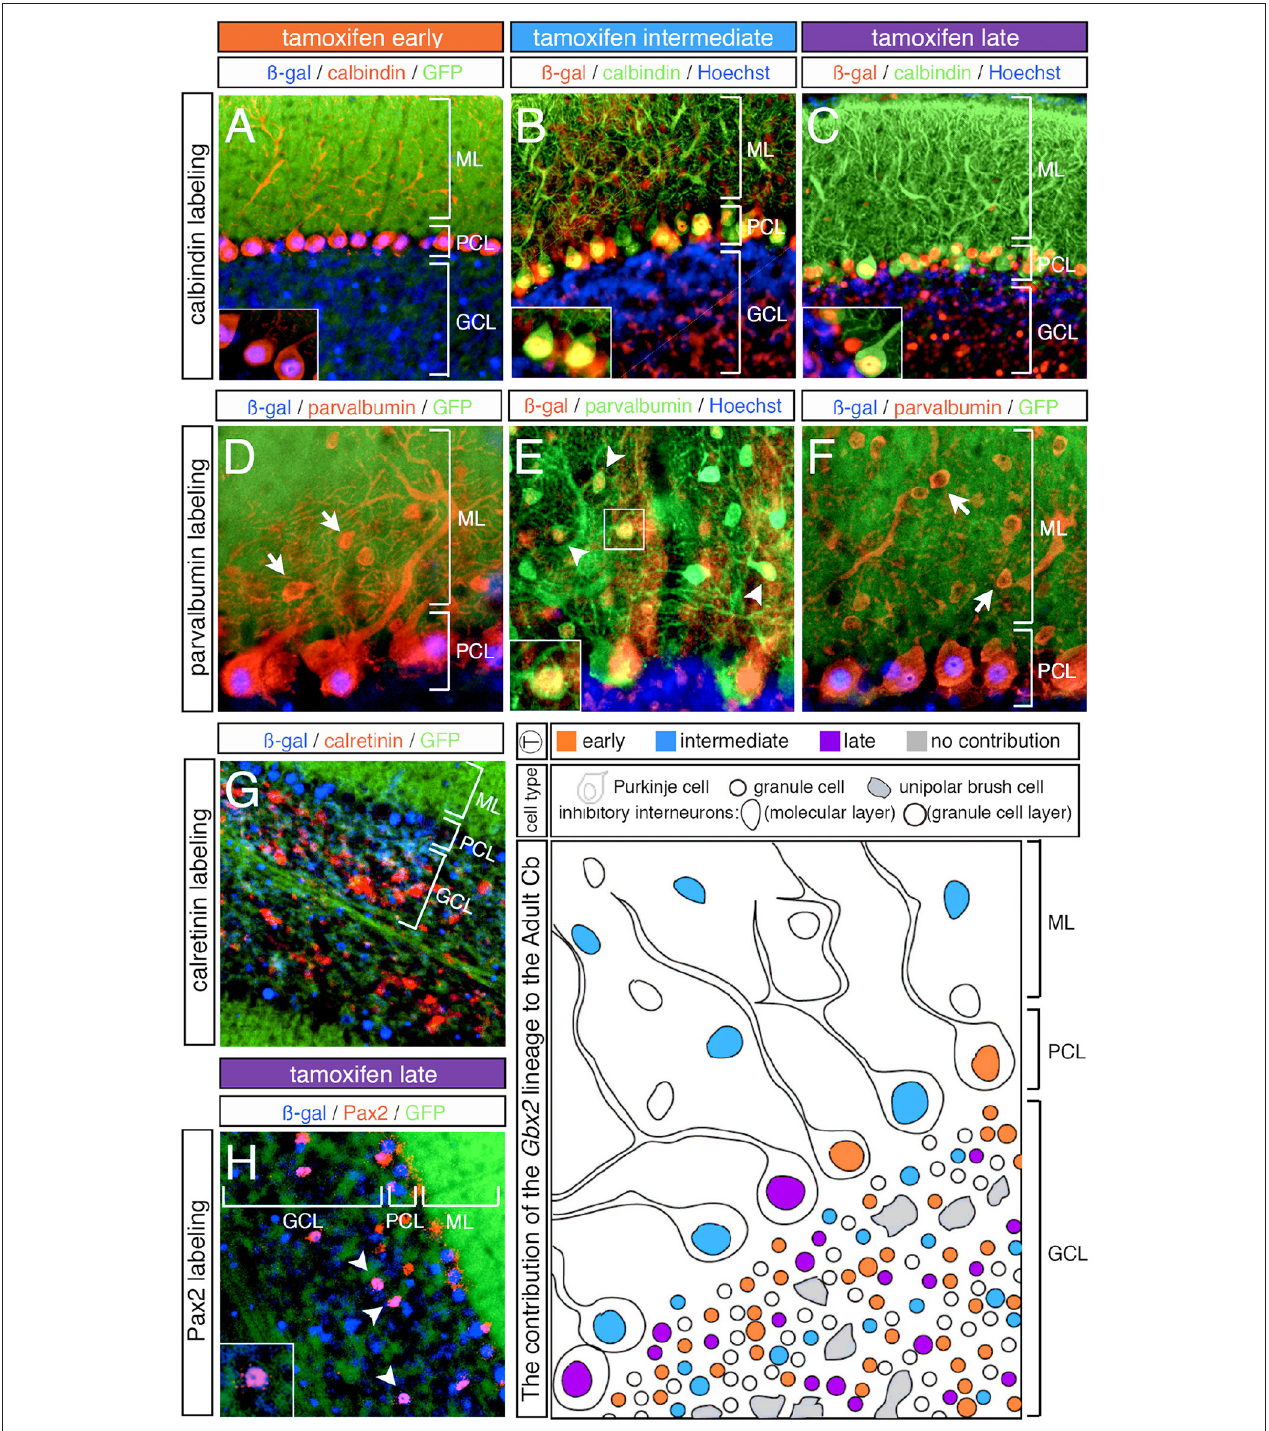
FIGURE 6 | Overview of Purkinje cell marker analysis in the Gbx2 lineage. ICC on adult sagittal sections with antibodies against ß-gal or GFP and cell type specific biomarkers. (A–C) Gbx2 expressing progenitors contributed to calbindin + Purkinje cells at all stages of marking. (D–F) The Gbx2 lineage gave rise to parvalbumin + Purkinje cells at all stages of marking, but only produced parvalbumin + inhibitory interneurons with marking at E9.5. (G) Gbx2 expressing progenitors failed to contribute to calretinin + unipolar brush cells all stages of marking. (H) The Gbx2 lineage gave rise to a few Pax2 + inhibitory interneurons at all stages of marking. Schematic summarizing the contribution of the Gbx2 lineage to granule cells, Purkinje cells, inhibitory interneurons, and unipolar brush cells at early (E7.5-E8.5, orange), intermediate (E9.5, blue) and late (E10.5-E11.5, purple) marking stages. Abbreviations: ML, molecular layer; PCL, Purkinje cell layer; GCL, granule cell layer. Scale bars: 90 µ m (A–C,G) , 46 µ m (D–F,H) . See Supplemental Figure 3 for fate mapping summary of Gbx2 lineage contribution to Purkinje cells at early, intermediate, and late marking stages.